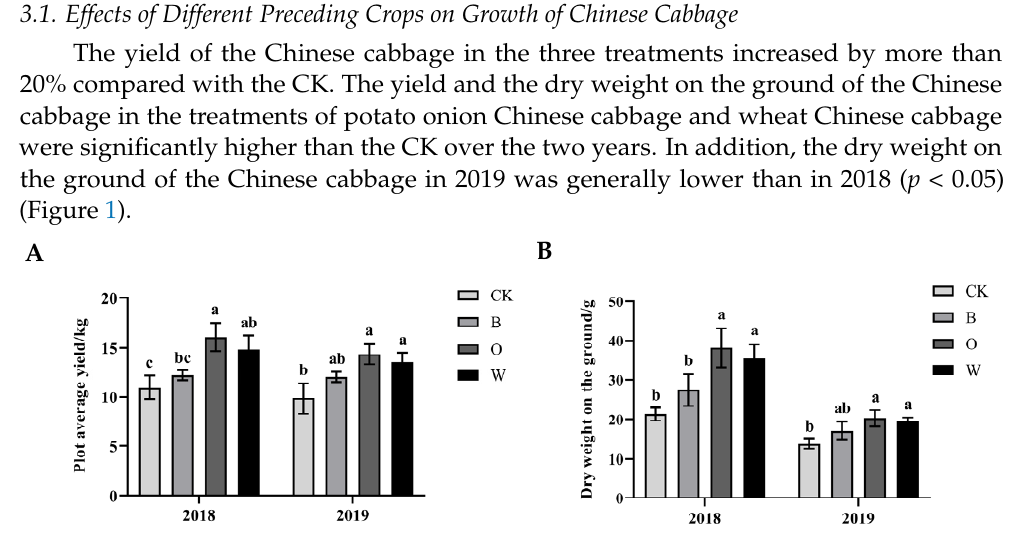
Figure 1. Effects of different preceding crops on yield ( A ) and dry weight on the ground ( B ) of Chinese cabbage. CK represents Chinese cabbage continuous cropping; B, O, and W represent bean, potato onion, and wheat rotation respectively. Different letters are significantly different; the results are for the statistical analysis within each year ( p < 0.05, Tukey’s HSD test).